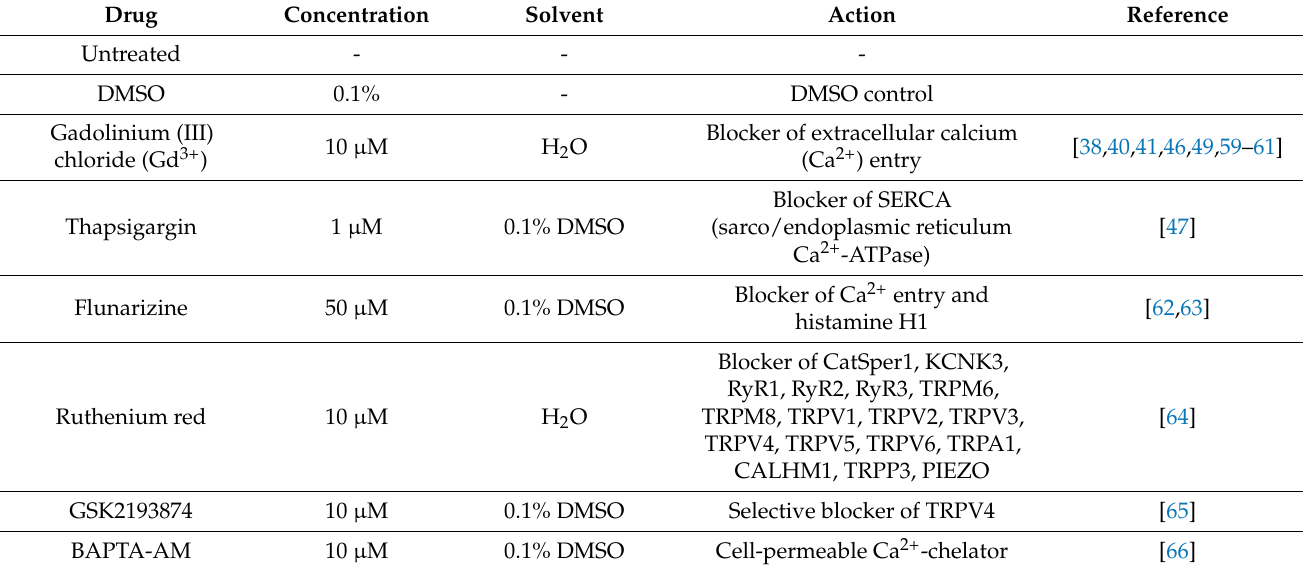
Table 1. Drugs applied during the